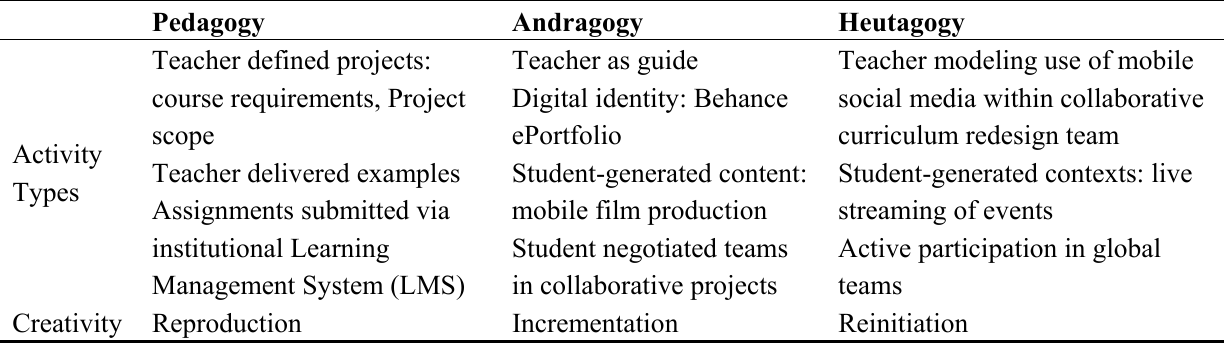
Table 9. Mobile social media in the Communication Design